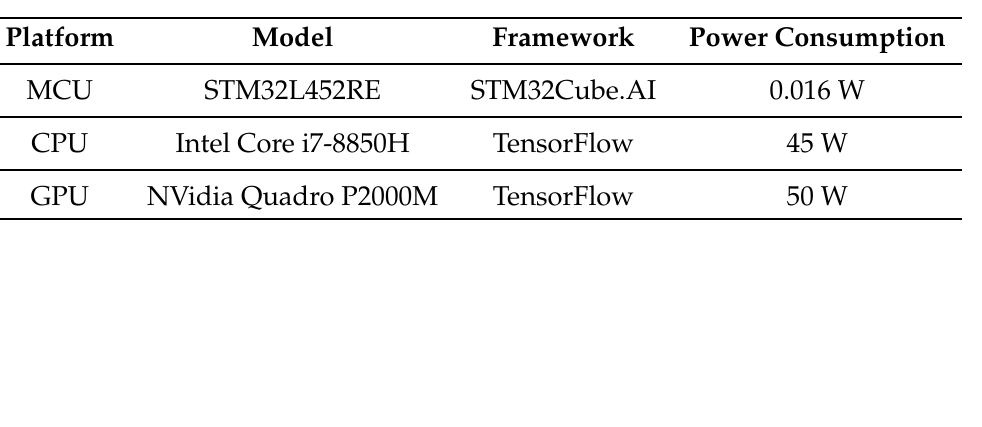
Table A1. Microcontroller (STM32L452RE), CPU (Intel Core i7-8850H) and GPU (NVidia Quadro P2000M) platforms. Power consumption figures for GPU and CPU are the TDP values from the manufacturer and do not reflect the exact power consumption of the